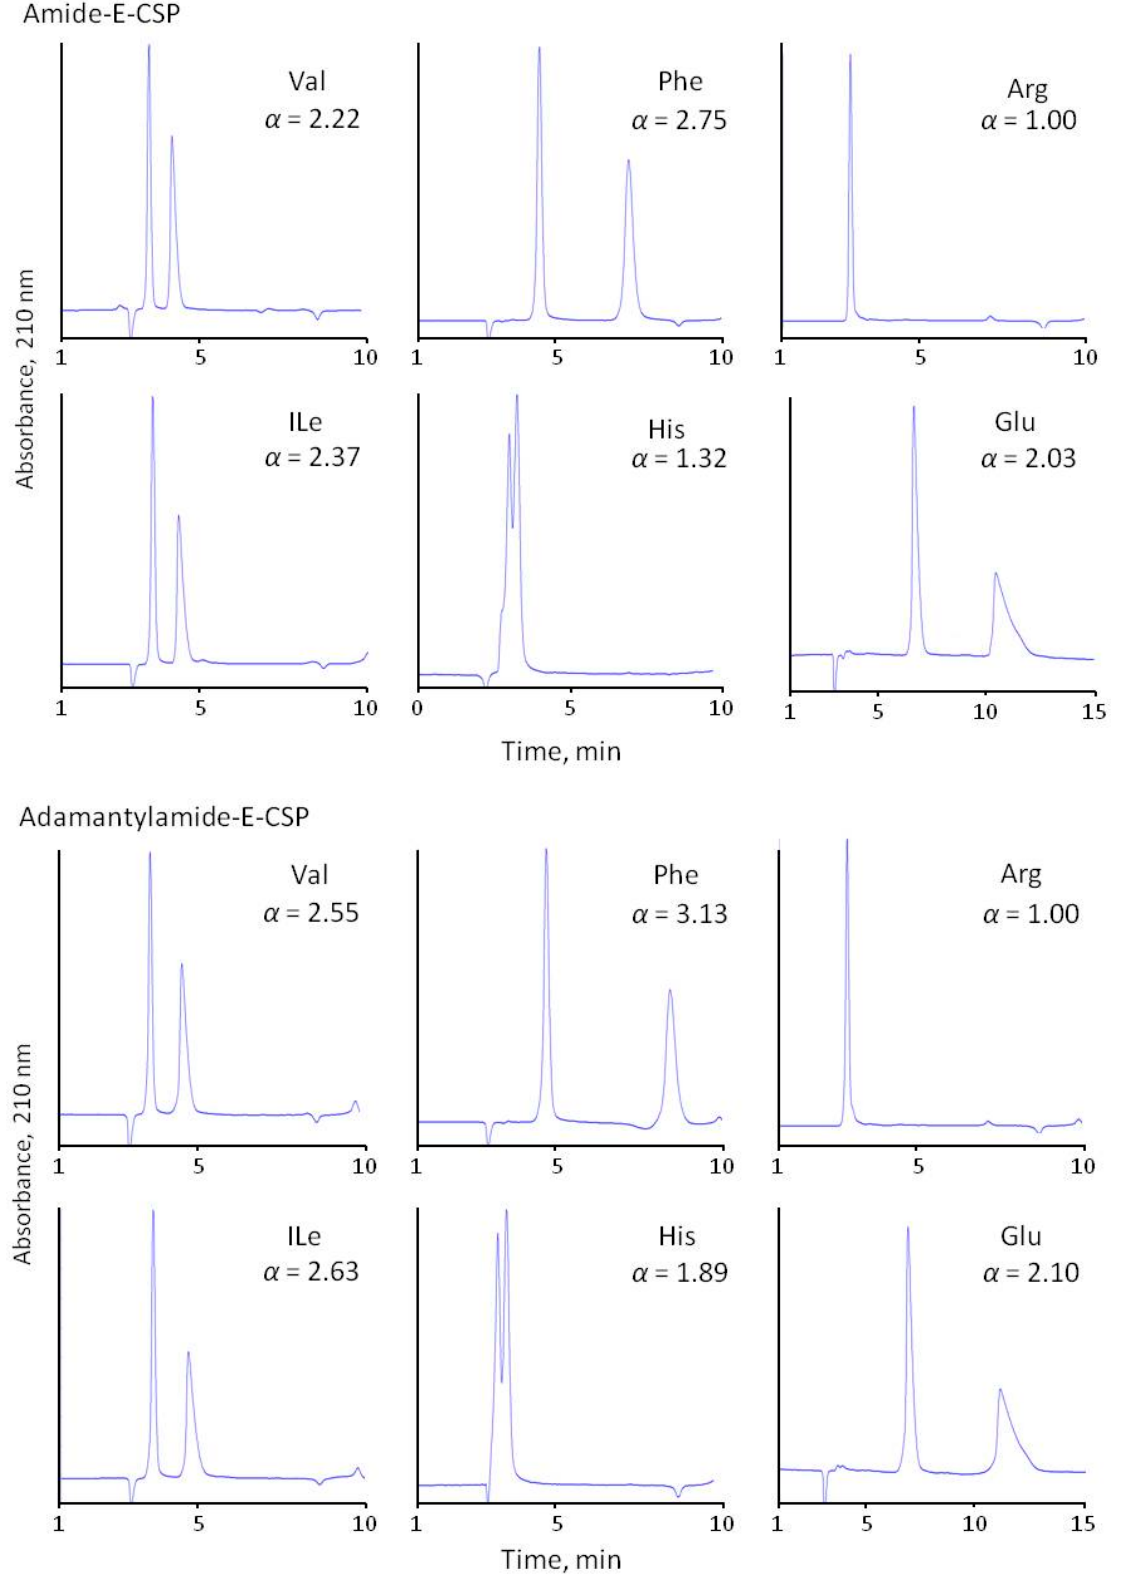
Figure 4. Separation of common (Val, Ile), aromatic (Phe, His), basic (Arg), and acidic (Glu) amino acids with four CSPs. Eluent 10% of methanol and 90% of 0.1 M sodium dihydrophosphate buffer with pH